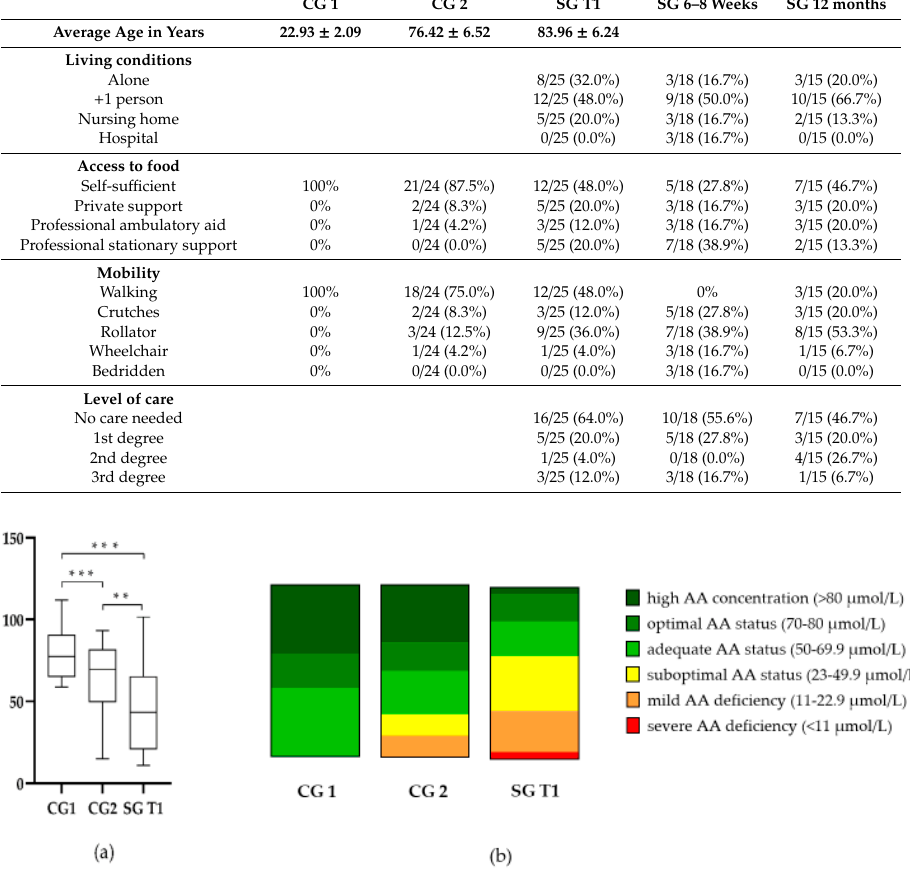
Figure 2. AA plasma concentrations of study group during hospitalization. Plasma samples were